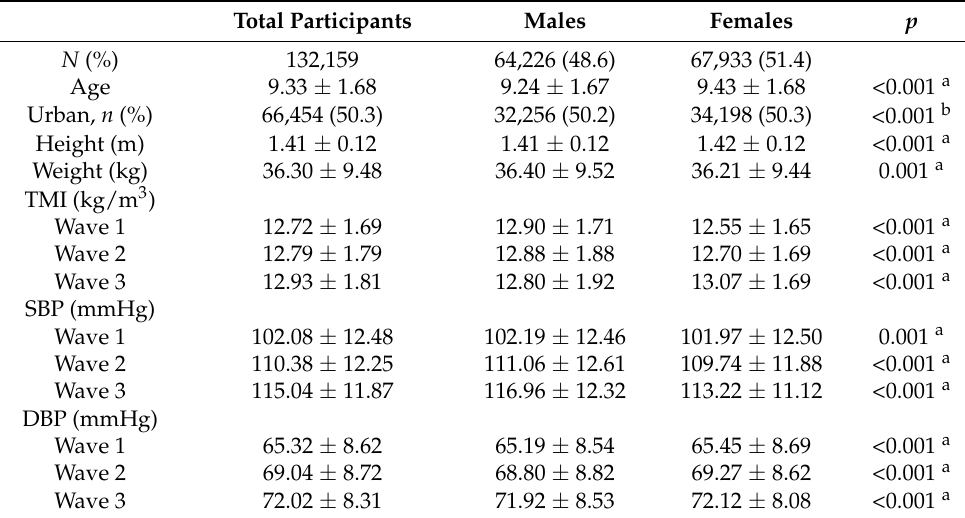
Table 1. Descriptive statistics of the participants in this study.